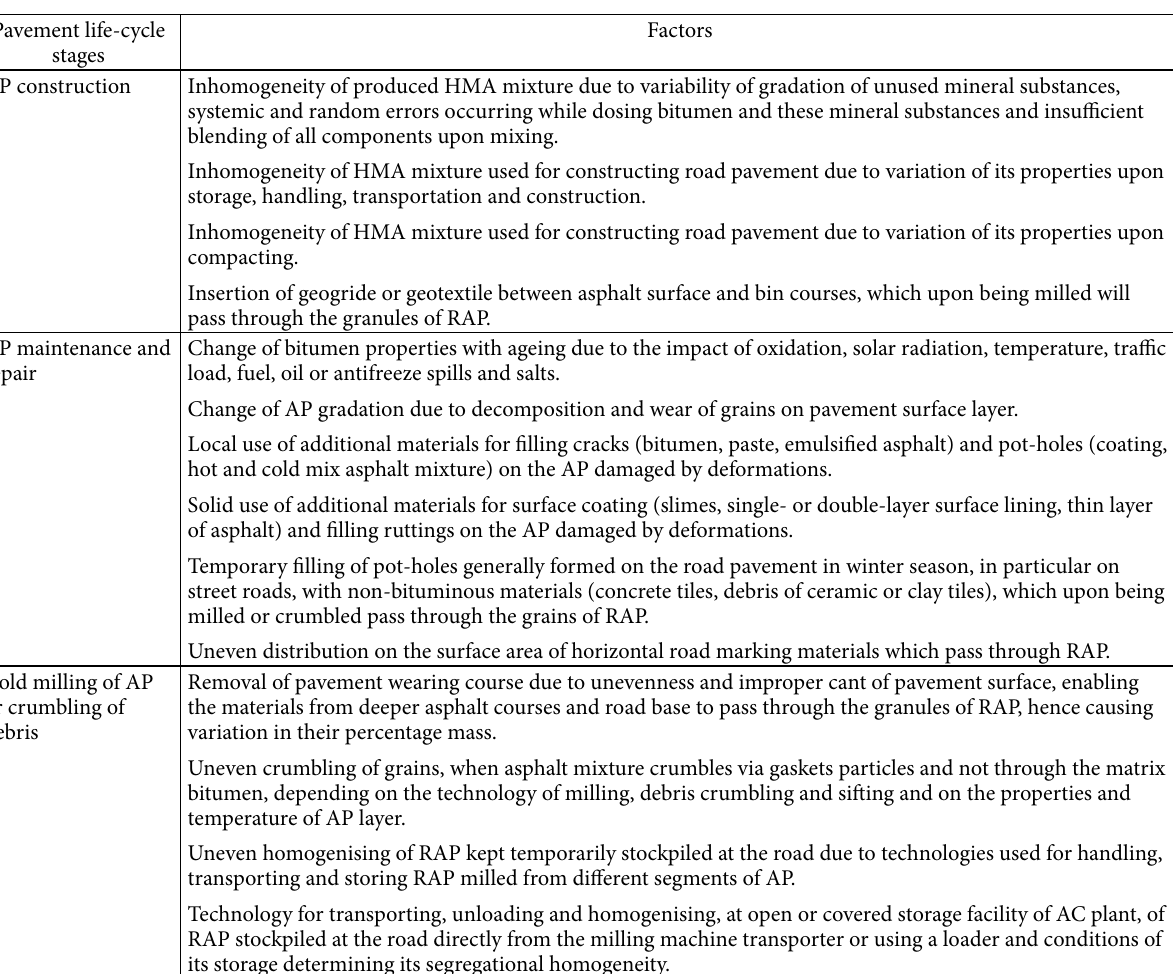
Table 1. Factors determining the inhomogeneity of milled RAP granules Pavement life-cycle stages